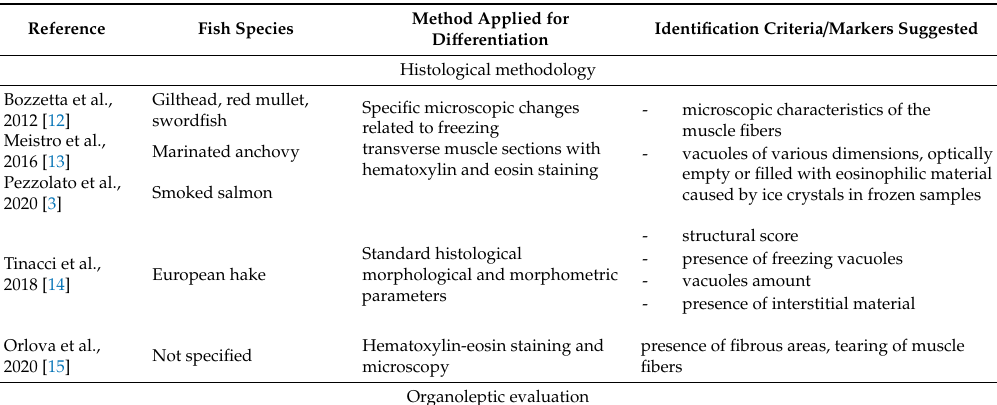
Table 1. Literature data regarding the studies that di ff erentiate fresh from frozen / thawed